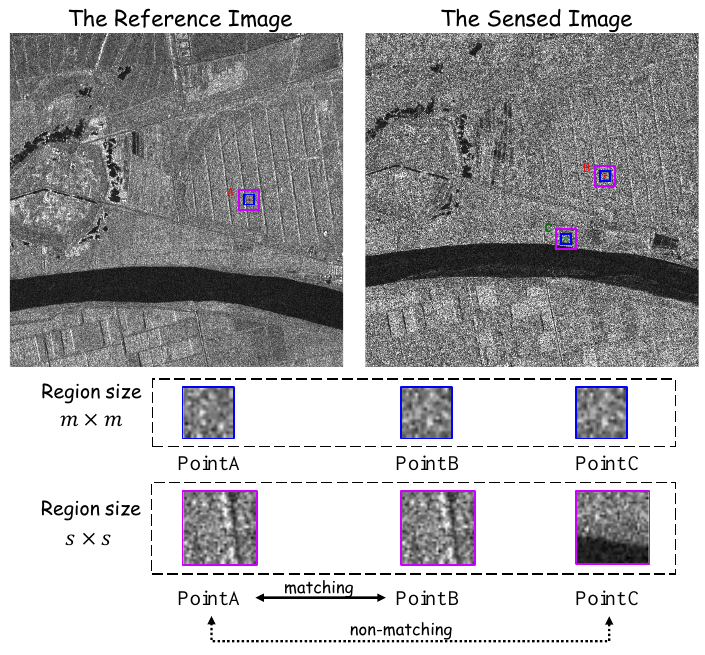
Figure 1. Patches with different